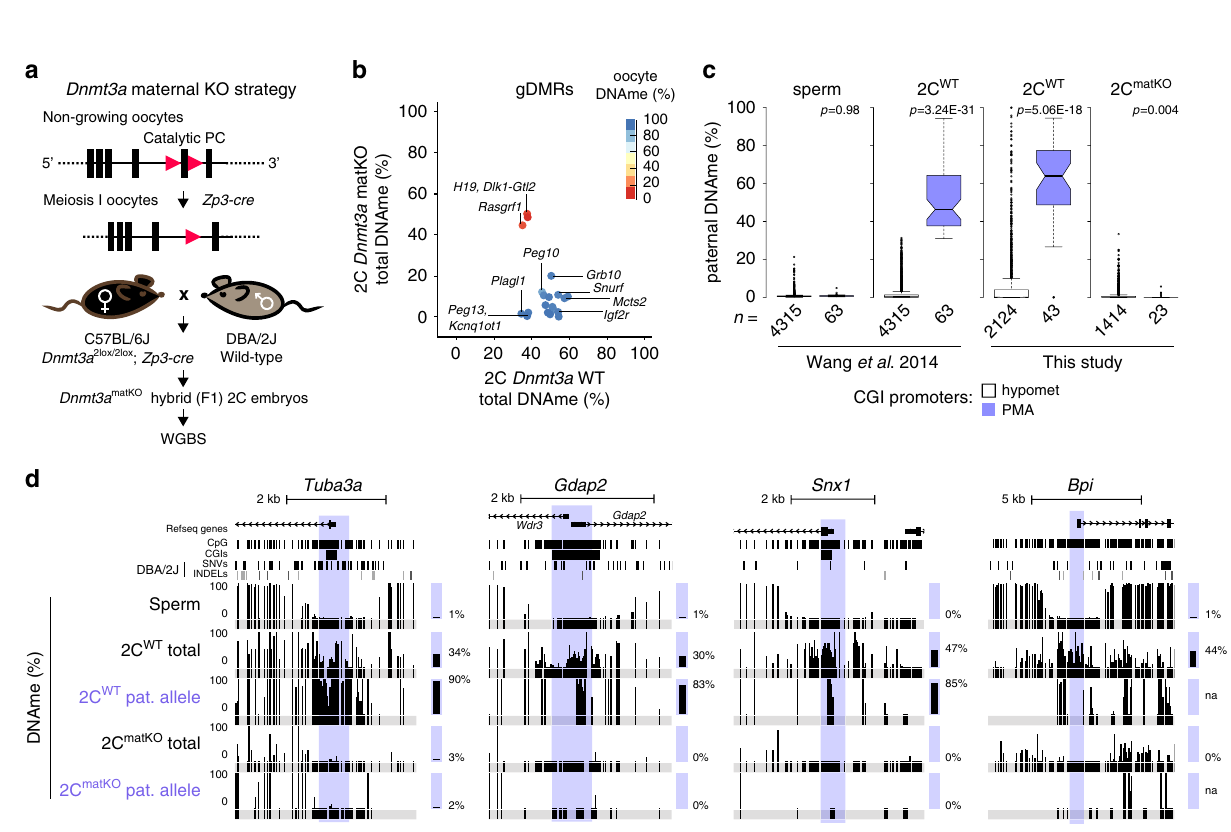
Fig. 3 PMA genes not expressed in oocytes are enriched for repressive histone marks. a Parallel-coordinate plot showing the temporal expression pattern of genes that show PMA in the male germline (SG to diplotene) and from the paternal allele the early embryo (1C to ICM). SG: spermatogonia. Lines representing paternal allele expression in the preimplantation embryo are colour coded based on CGI promoter DNAme levels observed in androgenetic blastocysts (<10% DNAme, n = 45 and ≥ 10% DNAme, n = 18) and the threshold for scoring genes as expressed (RPKM ≥ 1) is indicated. The distribution of RPKM values for each developmental stage are shown as boxplots below. Boxplots elements are as de fi ned in Fig. 1g. 6 PMA genes do not harbour exonic SNVs/INDELs and therefore could not be ascertained for paternal allele expression in F1 hybrid datasets (1C to ICM). b Mean DNAme (%) and expression (RPKM) levels in GV oocytes (data exclude polar bodies) over CGI promoters that undergo PMA. Hypermethylation and expression cut-off values (80 and 2, respectively) are indicated by dotted lines. Coloured dots are de fi ned as hypomethylated in GV oocytes. c , e Genome browser screenshot of the Tuba3a and Bpi loci, including MII oocyte DNAme, H3K27me3 ChIP-seq and RNA-seq tracks, presented as in Fig. 1. d Enrichment of H3K27me3 fl anking the same CGI promoters ( + / − 10 kb) as in b in MII oocytes and the maternal allele of 2C embryos. Source data are provided as Source Data fi le.